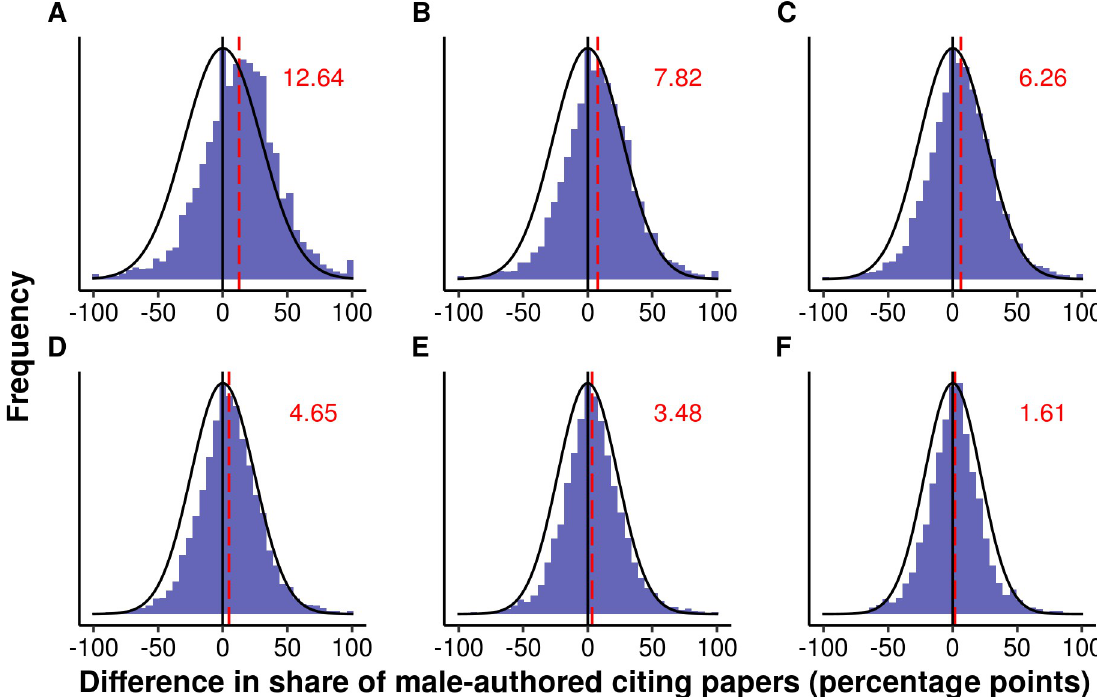
Fig 4. Histograms for the differences in the share of male-authored citing papers for pairs of focal papers (Faculty Opinions). In each histogram, the pairs of focal papers are restricted to those cases in which one focal paper is authored only by male scientists and the other focal paper is authored only by female scientists. Positive differences result when the male-authored paper of a pair has a higher share of male-authored citations than the female-authored paper of this pair. The histograms differ in terms of the minimum number of shared keywords that the pairs of focal papers have, and–as a consequence–in the number of pairs of focal papers included: all 11,702,080 pairs in (A), 765,642 pairs with at least one shared keyword in (B), 223,837 pairs with at least two shared keywords in (C), 58,465 pairs with at least three shared keywords in (D), 14,167 pairs with at least four shared keywords in (E), and 3,010 pairs with at least five shared keywords in (F). The vertical lines are placed at 0 (black) and at the observed average difference (red, dashed). The black curve shows the shape of a normal